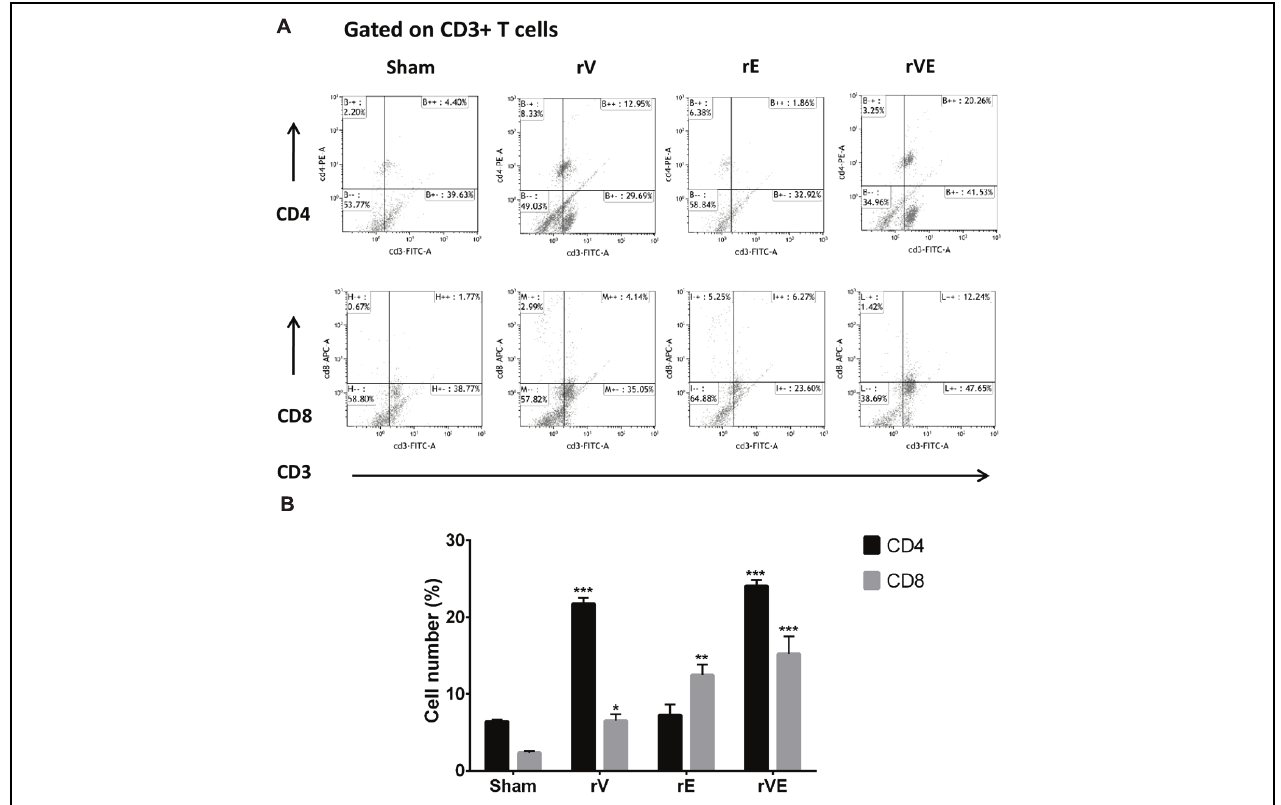
FIGURE 5 | The CD4 and CD8 T-cells were estimated by flow cytometric analysis using fluorescent tagged anti-CD3, anti-CD4, and anti-CD8 monoclonal antibodies. PBMCs isolated from three representative rV, rE, and rVE immunized mice after 24 h of IP challenge with Y. enterocolitica 8081 were used in the assay. (A) Representative graphs showing percentage of CD4 and CD8 T cells within gated CD3 T cell population. The percentage of gated T cells in each quadrant is shown. (B) The percentage CD4 and CD8 T cell population in immunized and sham immunized mice. ∗ P < 0.05; ∗∗ P < 0.01; ∗∗∗ P < 0.001 compared to sham immunized mice CD4 and CD8 T cell